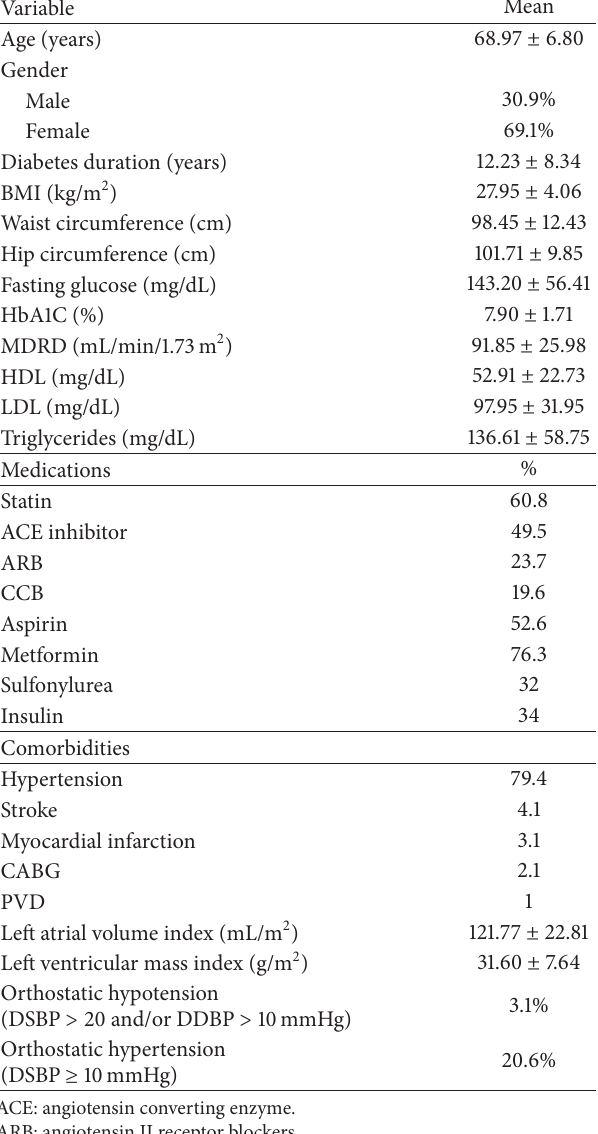
Table 1: Clinical, laboratorial, and echocardiography characteristics of studied